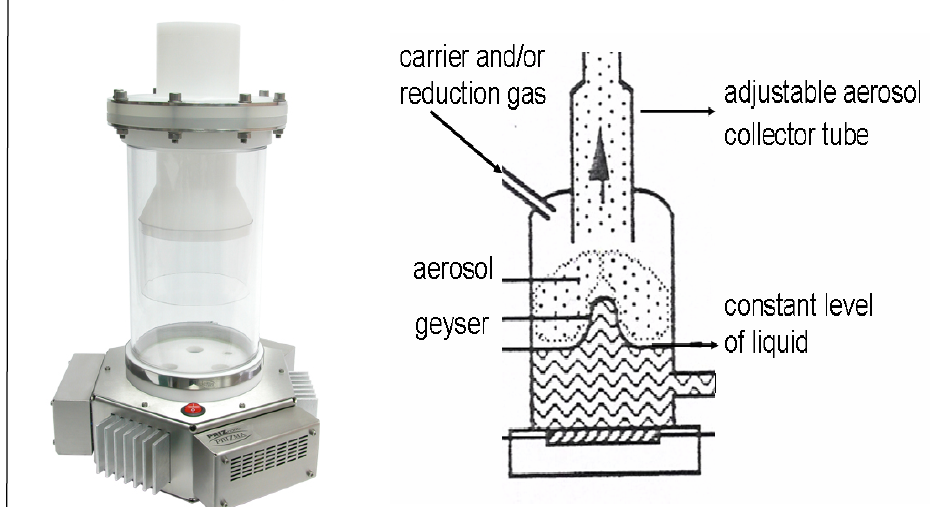
Fig. 1 – Aerosol production by the ultrasonic atomiser by Prizma, Kragujevac Slika 1 – Proizvodnja aerosola pomocu ultrazvucnog rasprsivaca Prizma,